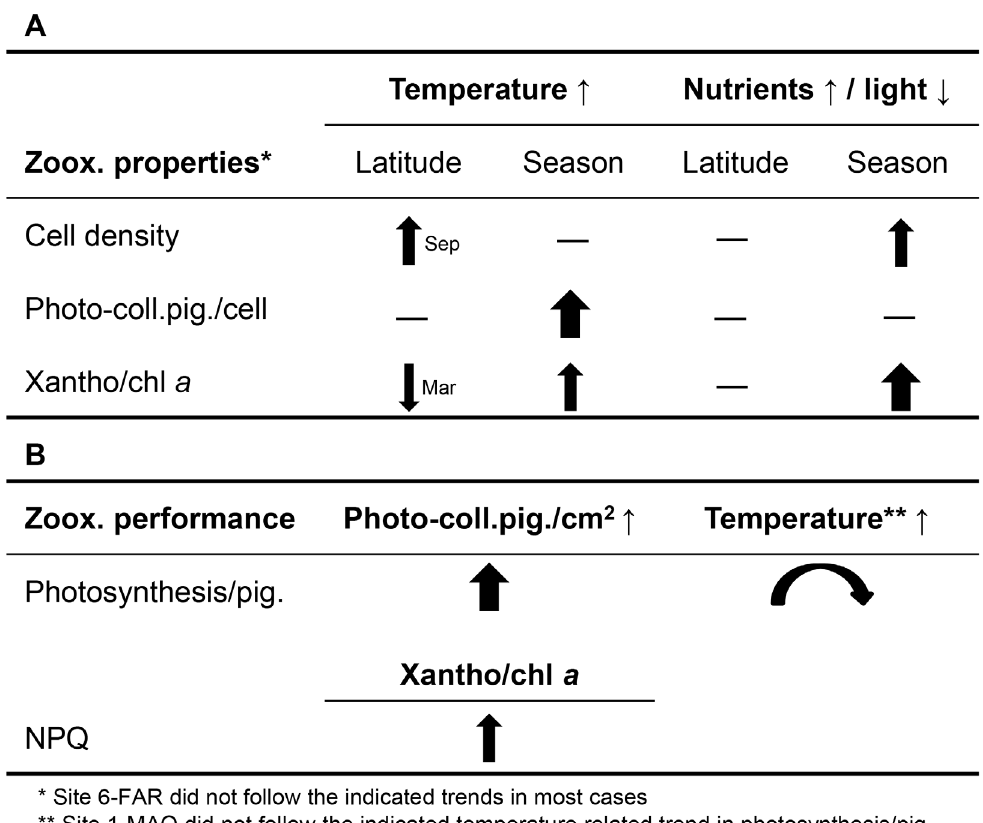
Figure 6. Summary of results. A ) Relationships found between the environmental parameters (temperature and nutrients/light) and the zooxanthellae (zoox.) properties (density, photo-collecting pigments/cell and xantho/chl a ratio [relative abundance of photo-protective pigments]) over the latitudes and between seasons. The addition Sep or Mar next to the arrow indicates the months of the observed latitudinal trend. B ) Relationships found between zooxanthellae properties and zooxanthellae performance and between zooxanthellae performance (here only photosynthesis standardized to photo-collecting pigments [photosynthesis/pig.]) and temperature. The directions of the arrows indicate an increase (upward) or decrease (downward) of the corresponding zooxanthellae property or performance, the thickness indicates the relative strength of relationship.